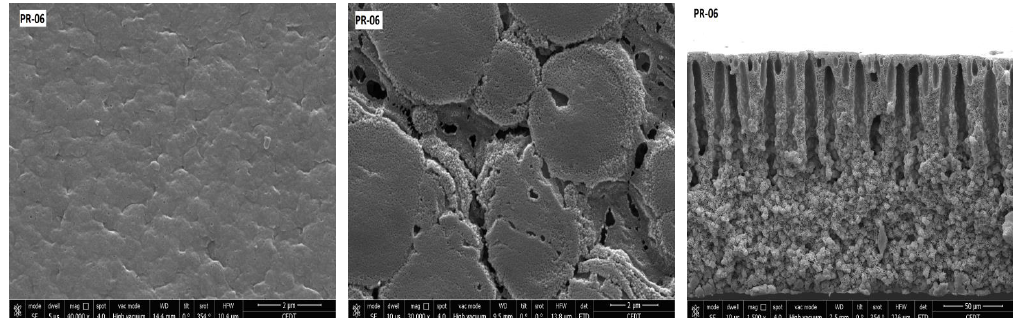
Figure 9. FESEM images of blended PVDF membranes films. Components of the dope solution: 25 wt % Solef ® 6020 PVDF homopolymer and Solef 90 ® 21015 PVDF copolymer, 75 wt % NMP as a solvent. Percentage of the copolymer in the overall PVDF blend: PR-04: 20%, PR-05: 28%, PR-6: 40%.